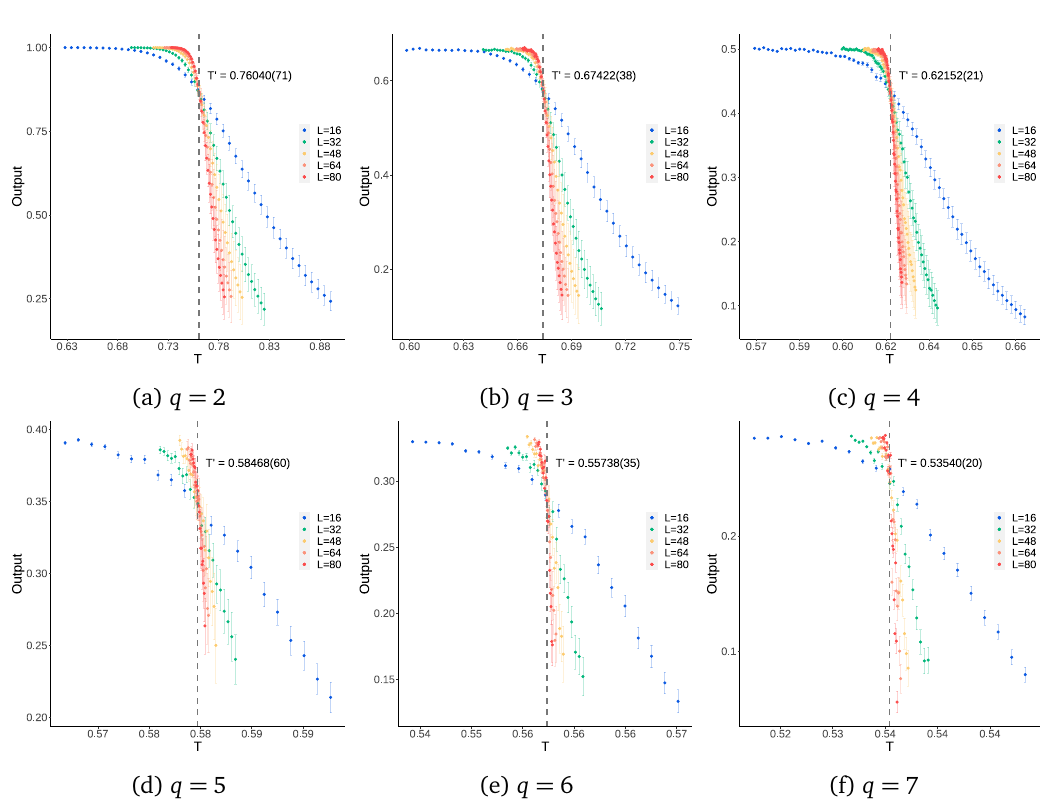
Figure 14: The relationship between temperature and the average output of an en- semble of 10 independently trained ANNs – training with simplified data, and testing with MC data of the ferromagnetic q -state Potts model on a honeycomb lattice. The error bars shown are 99.7% confidence intervals of the ensemble average.